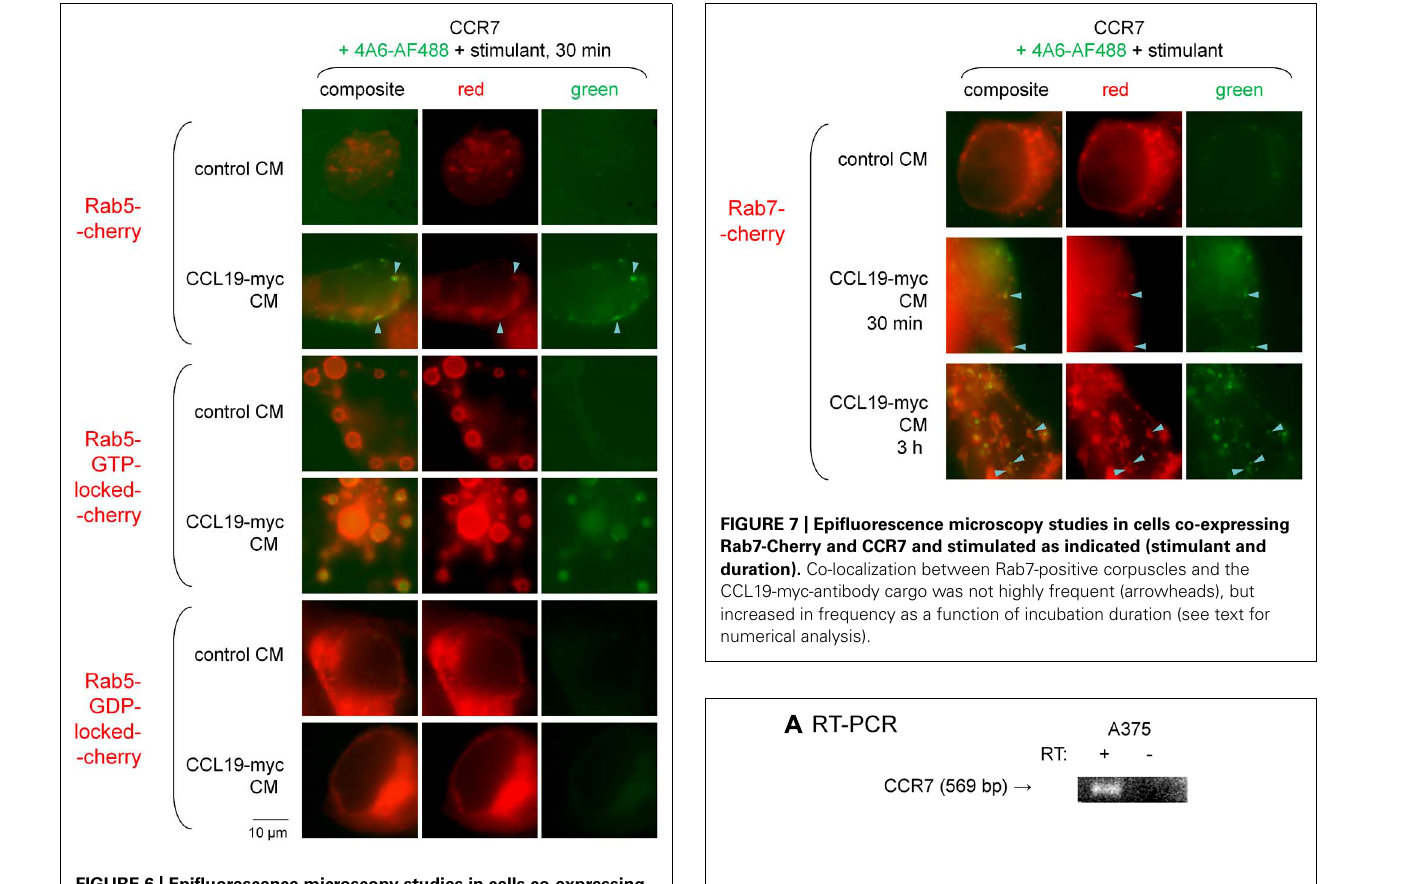
FIGURE 6 | Epifluorescence microscopy studies in cells co-expressing one of three forms of Rab5-Cherry fusion proteins and CCR7 and stimulated for 30 min with either CCL19-myc or control CM. Co-localization between Rab5-positive corpuscles and the CCL19- myc-antibody cargo was observed (arrowheads).The dominant positive (GTP-locked) mutant of the fusion protein produced typical giant vacuoles that included the green light-emitting cargo.The dominant negative Rab5-GDP-locked-Cherry inhibited the endocytosis of the green cargo (see text for numerical analysis).